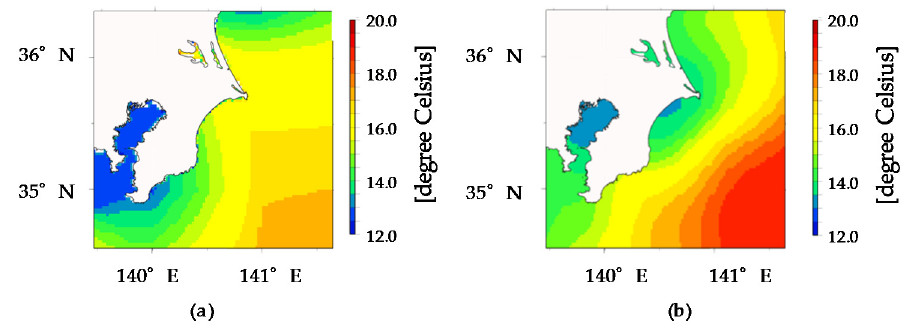
Figure 10. Sea surface temperature distribution on 01/02/2013 ( a ) FNL ( b ) OSTIA.